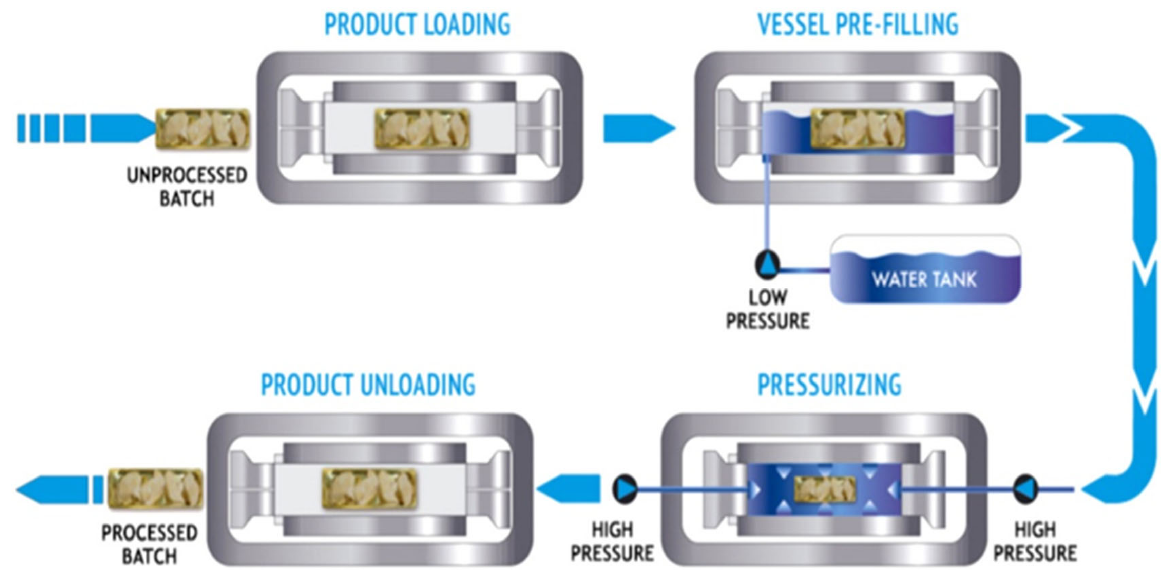
Figure 1. Diagram of high ‐ pressure processing (HPP), Reprinted with permission from Ref. [4], Copyright (2022) Elsevier.